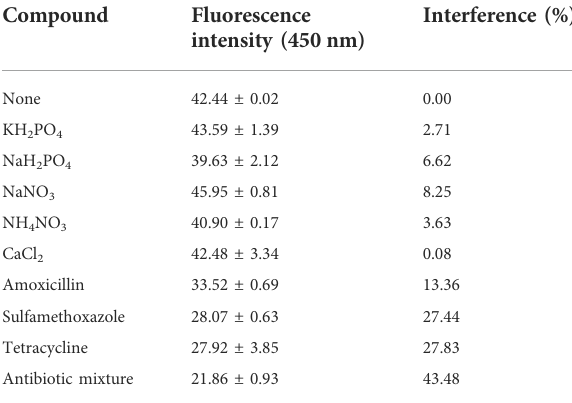
TABLE 4 Interferents for the biocatalytic method for ampicillin detection.